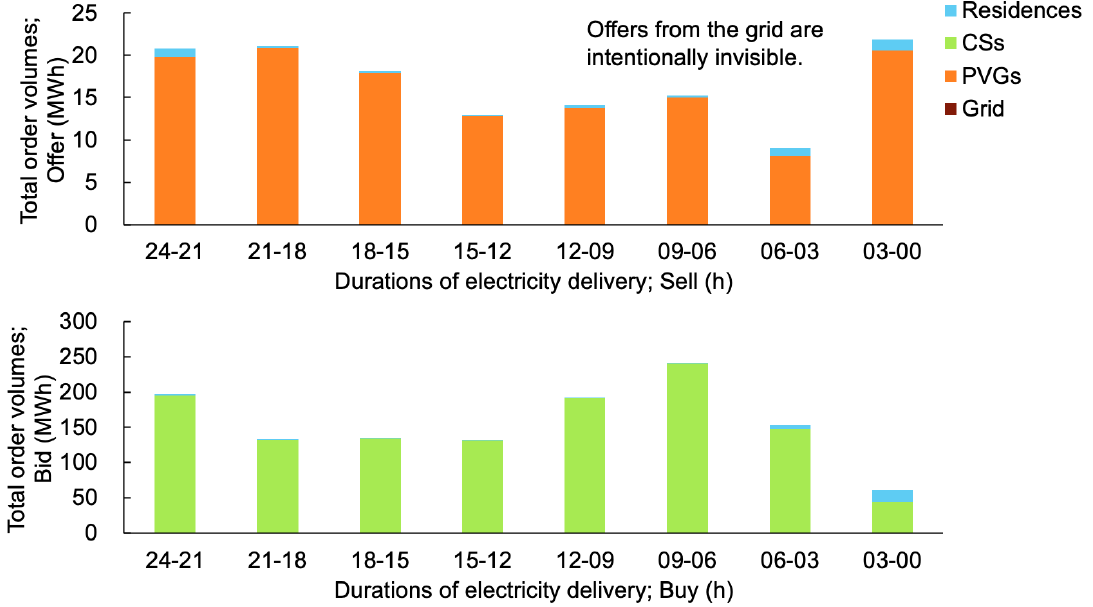
Figure 12. Total order volumes for each electricity delivery duration in the target period.